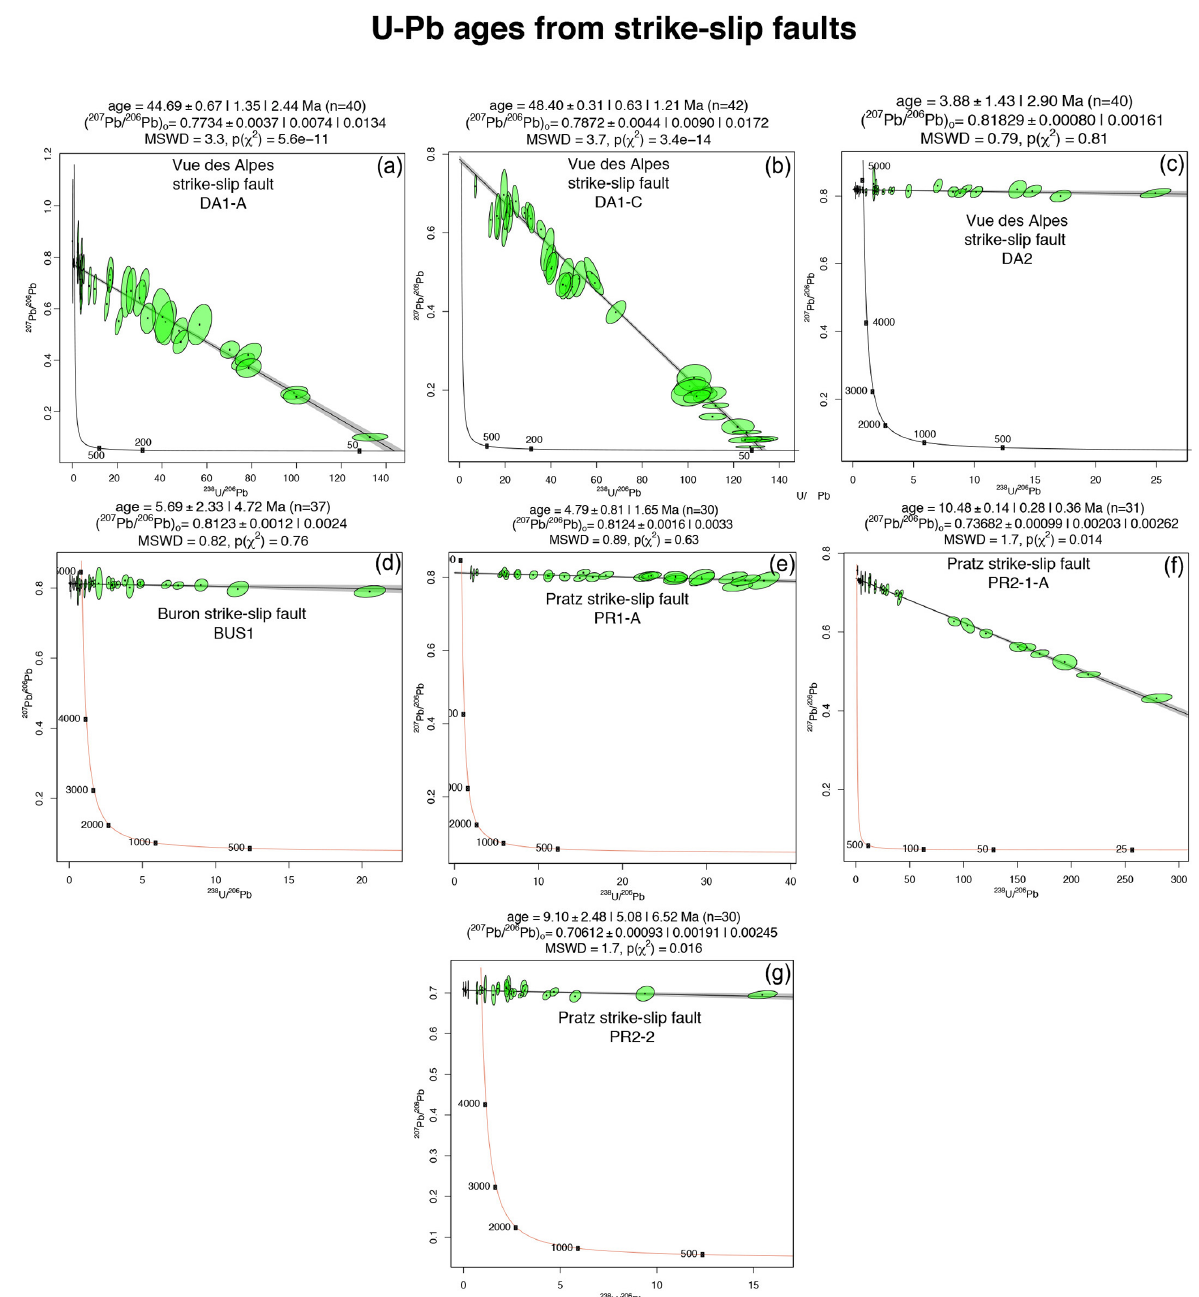
Figure 6. Tera–Wasserburg concordia diagrams of strike-slip faults. (a–c) Vue des Alpes strike-slip fault. (d) Buron strike-slip fault. (e–g) Pratz strike-slip